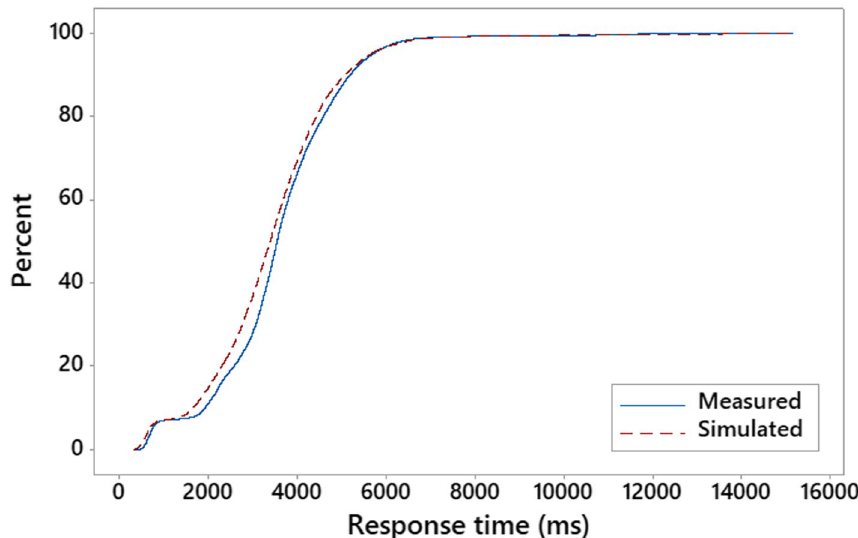
Fig. 9 ECDF plot of measured and simulated values of response time for rapid growth validation scenario, MRS service, medium